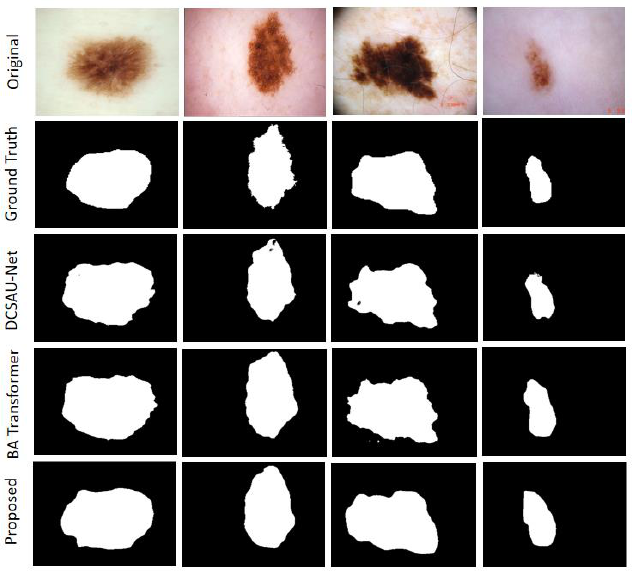
Figure 8. ISIC 2018 Segmentation output sample.